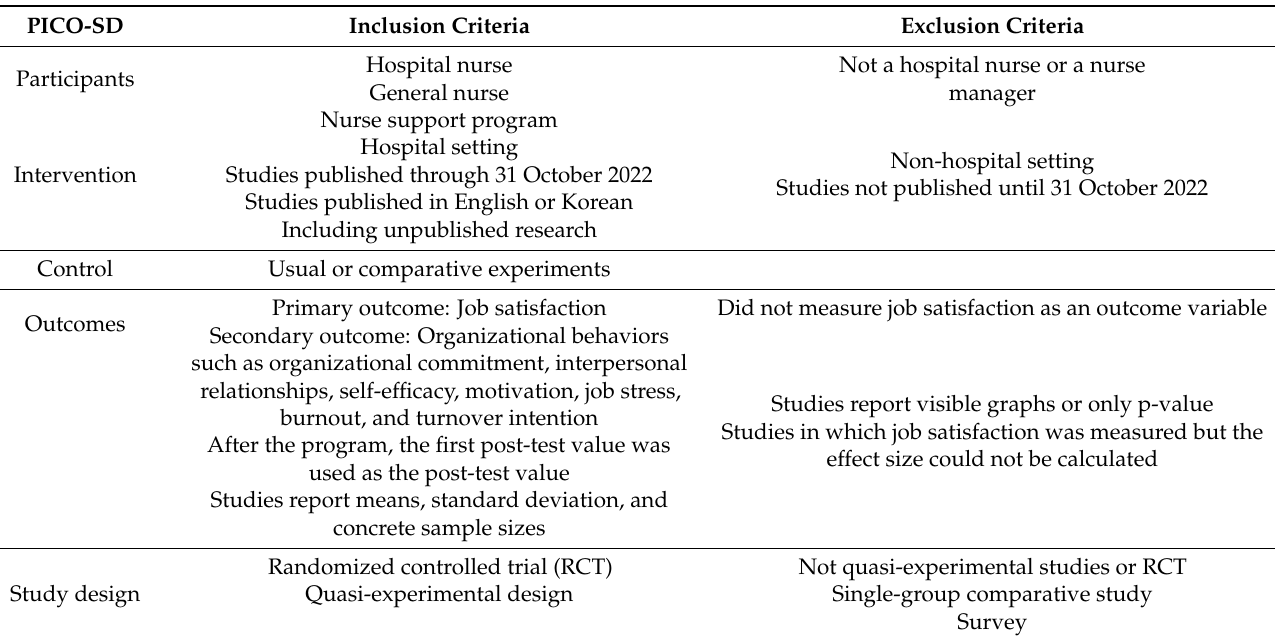
Table 1. Study eligibility